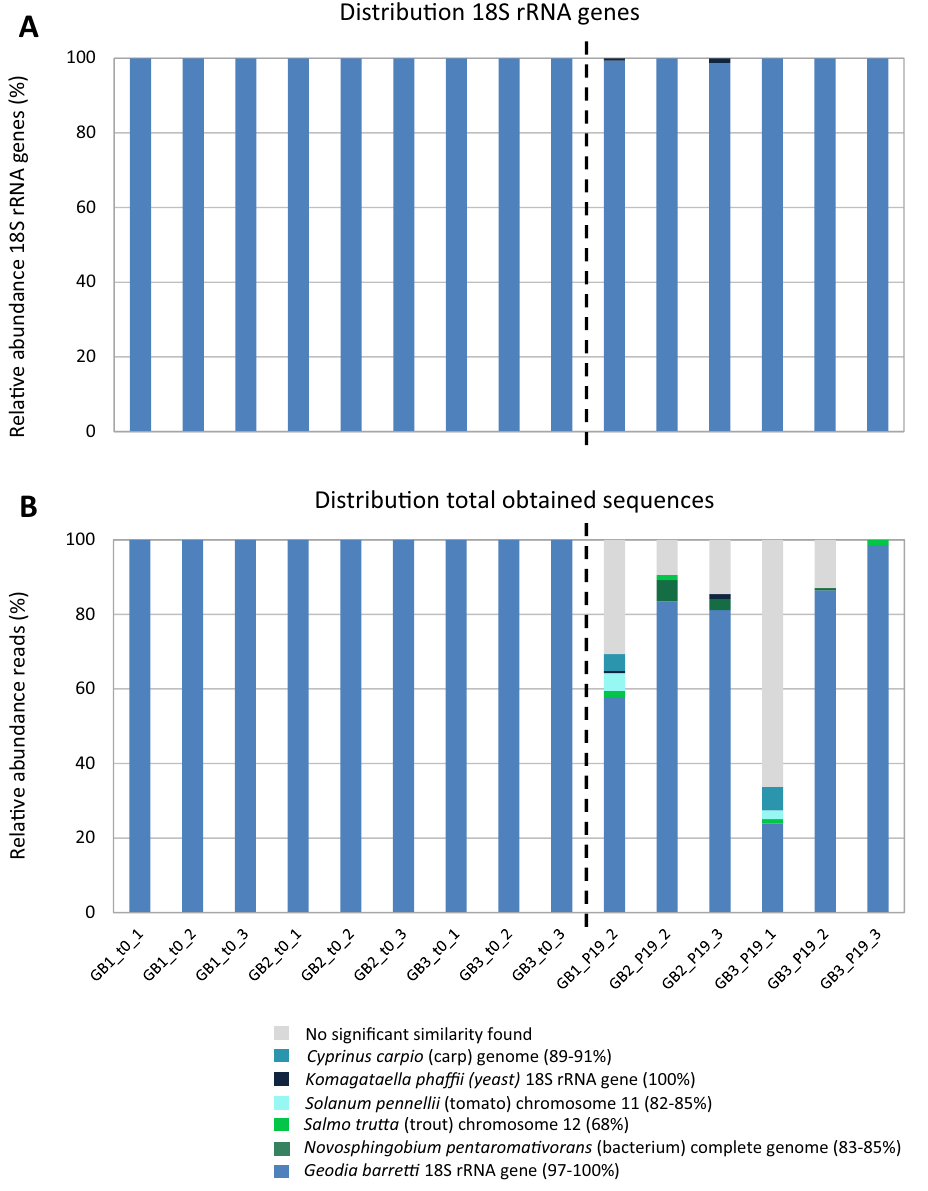
Figure 5. Eukaryotic community composition of G. barretti cell cultures. ( A ) Distribution of 18S rRNA genes in G. barretti cell cultures from the cell banks (t0) and after passage 19 (P19) separated by the dashed line. ( B ) Distribution of 18S rRNA gene sequences and other sequences that were generated from the cell banks (t0) and after passage 19 (P19). The color legend indicates the best Blastn hit obtained and in parentheses the percentage of